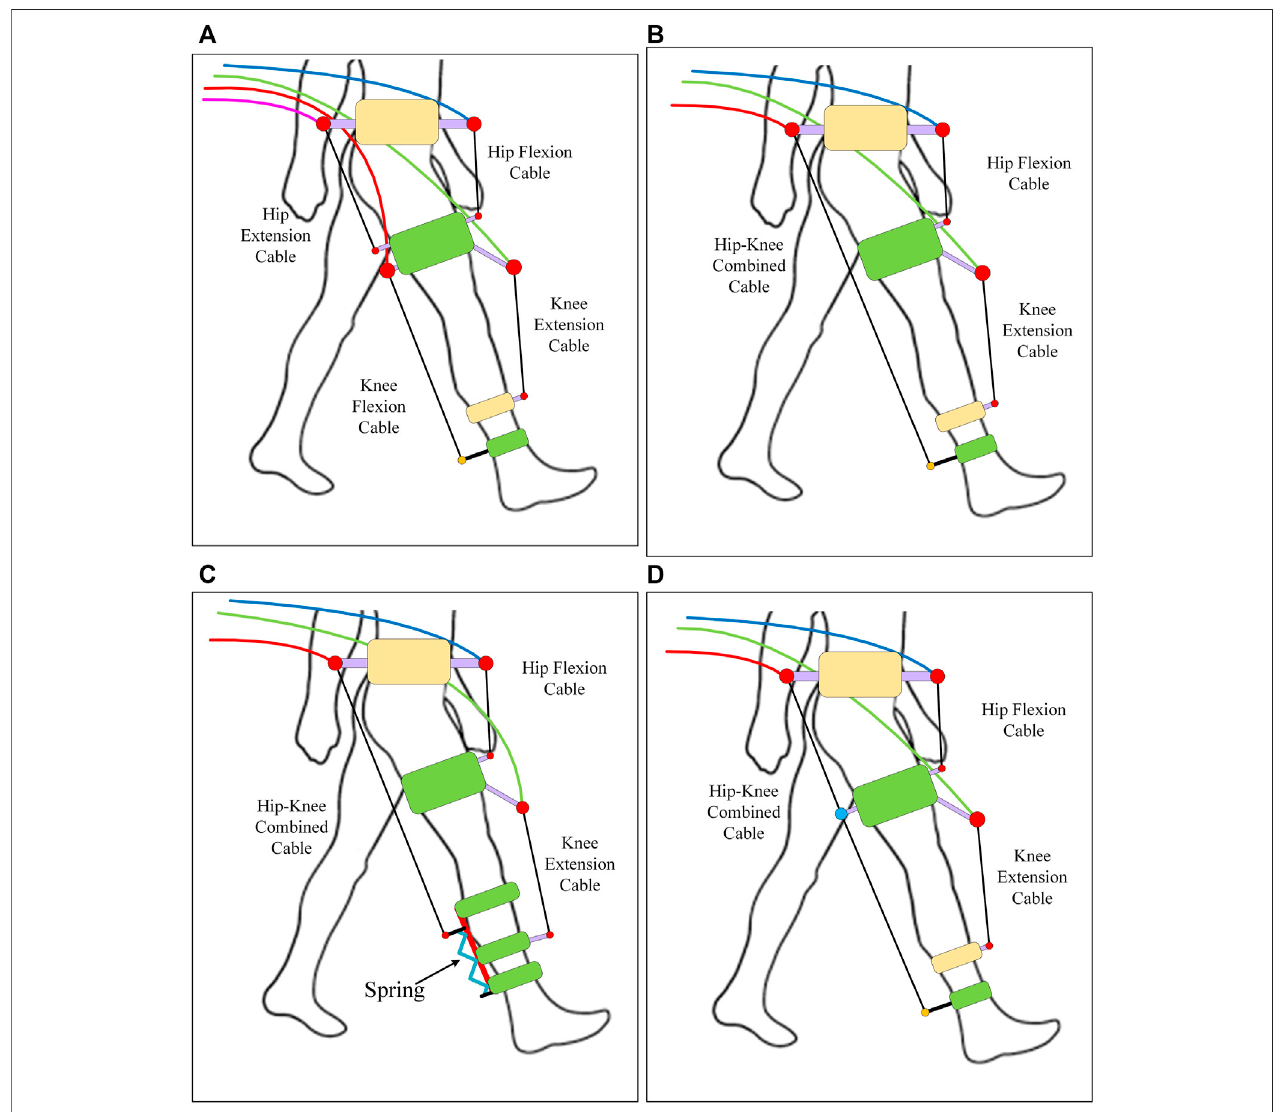
FIGURE 4 | Conceptual models: (A) Con fi guration 1 (B) Con fi guration 2, (C) Con fi guration 3, and (D) Con fi guration 4.